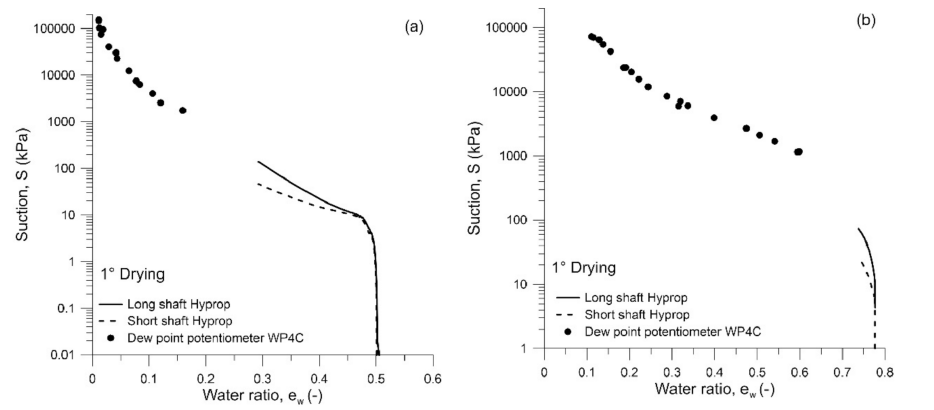
Figure 2. Water retention data of ( a ) Agrigento sand and ( b ) Leendert de Boerspolder